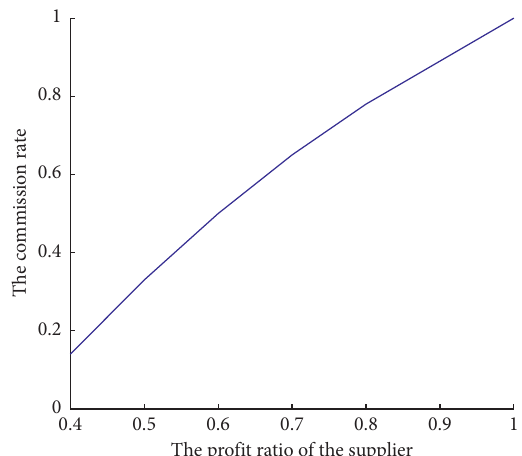
Figure 2: The commission rate in the decentralized